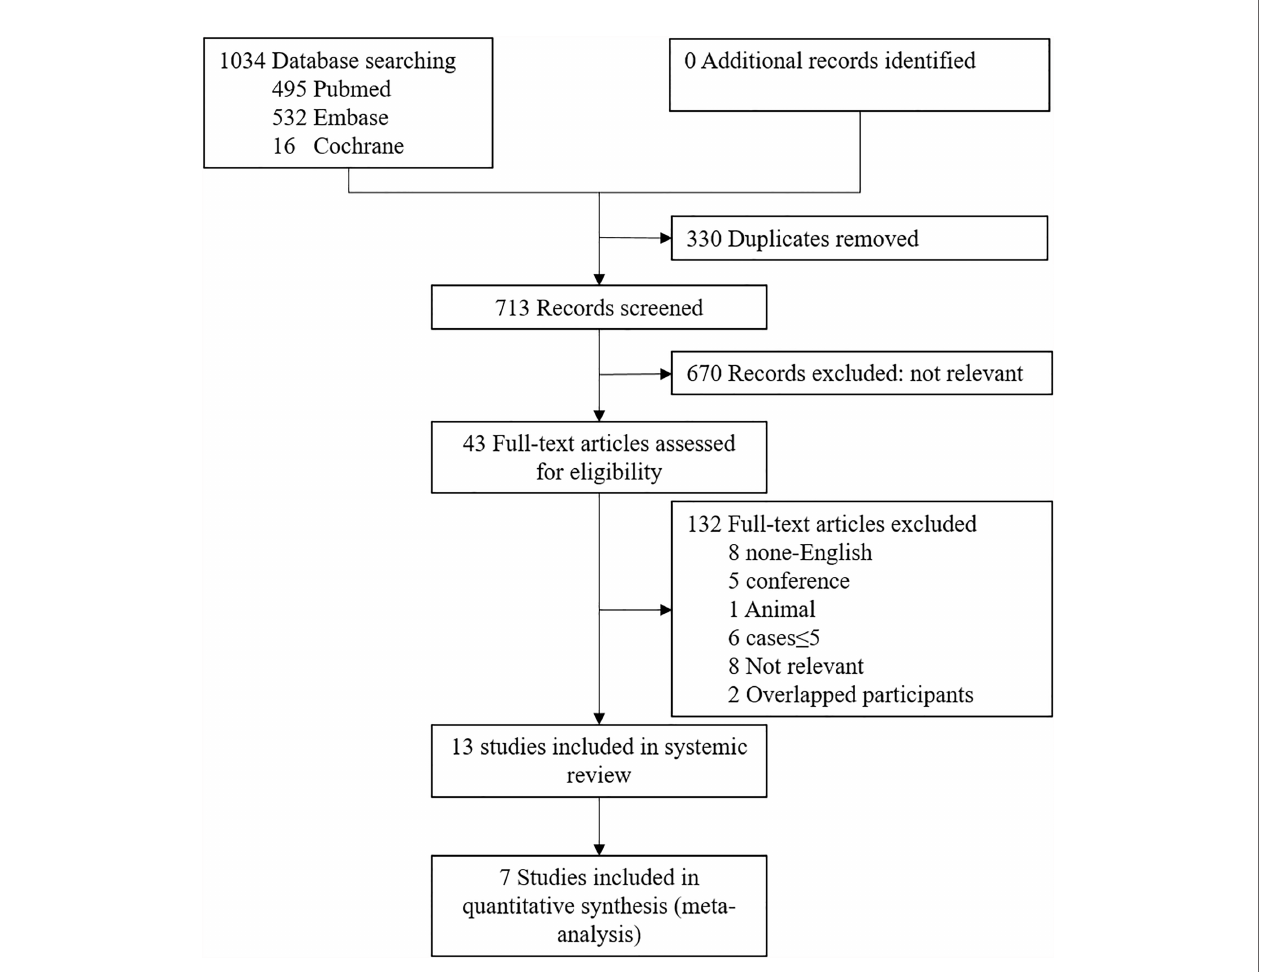
FIGURE 1 | Flow Diagram of the Literature